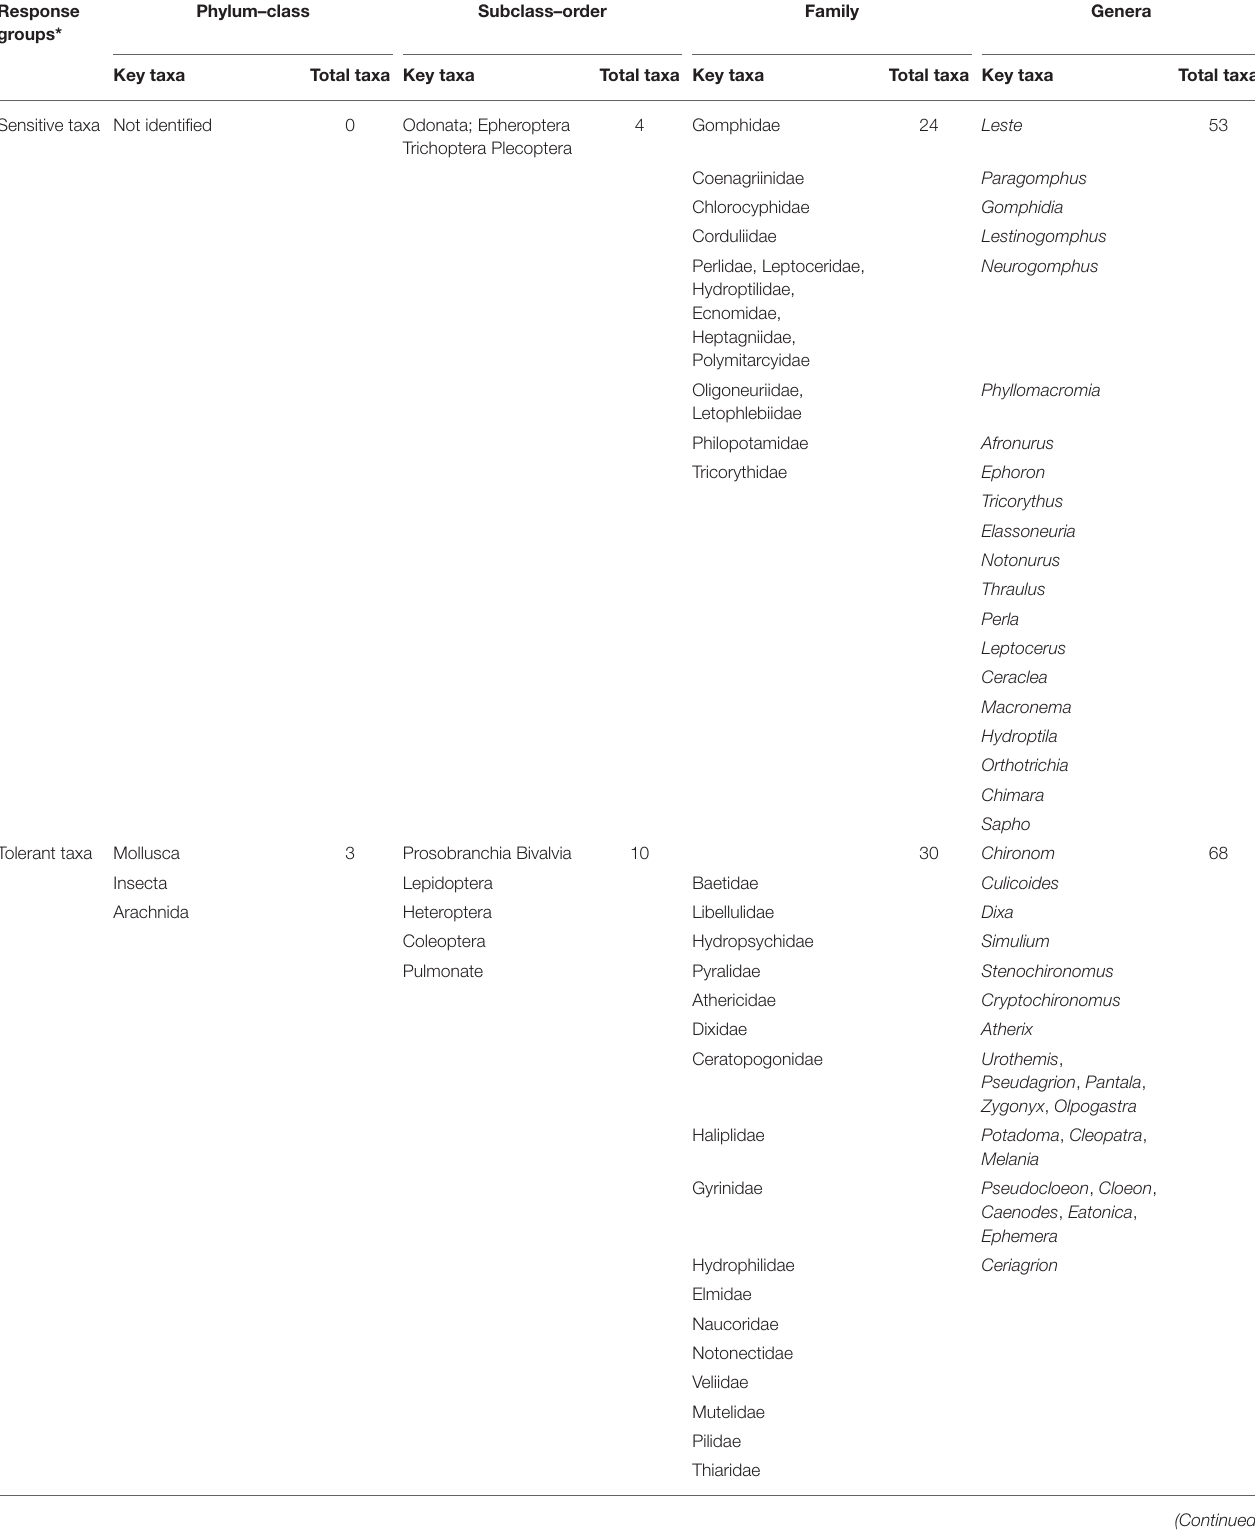
TABLE 3 | Key taxa as indicated by their respective response groups for their specific taxonomic levels. Response